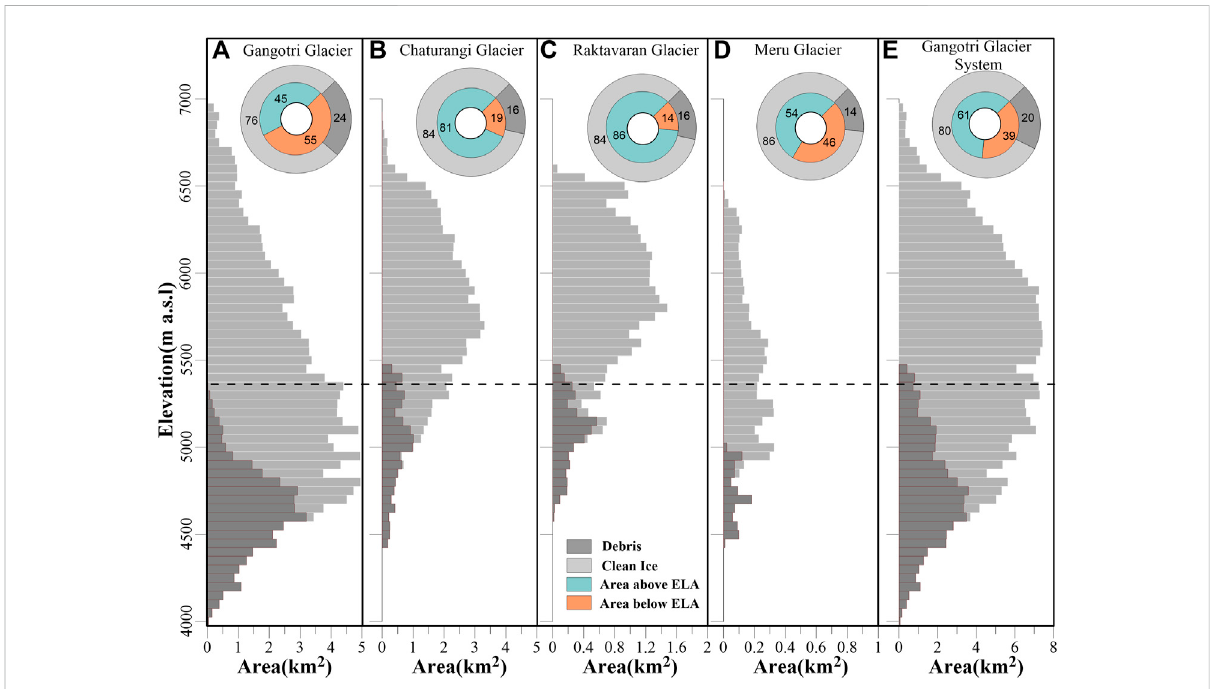
FIGURE 7 The 50-m hypsometry for four selected glaciers (A – D) and the Gangotri Glacier System (E) . Light grey bars represent the glacier area, and the dark grey bars represent thedebris-covered area on eachglacier. The outerpie charts show the percentage ofdebris-covered and clean-ice glacier surface area, and the inner pie charts show the areas below and above the equilibrium line altitudes (ELAs). The black dashed line is the mean ELA of the Gangotri Glacier